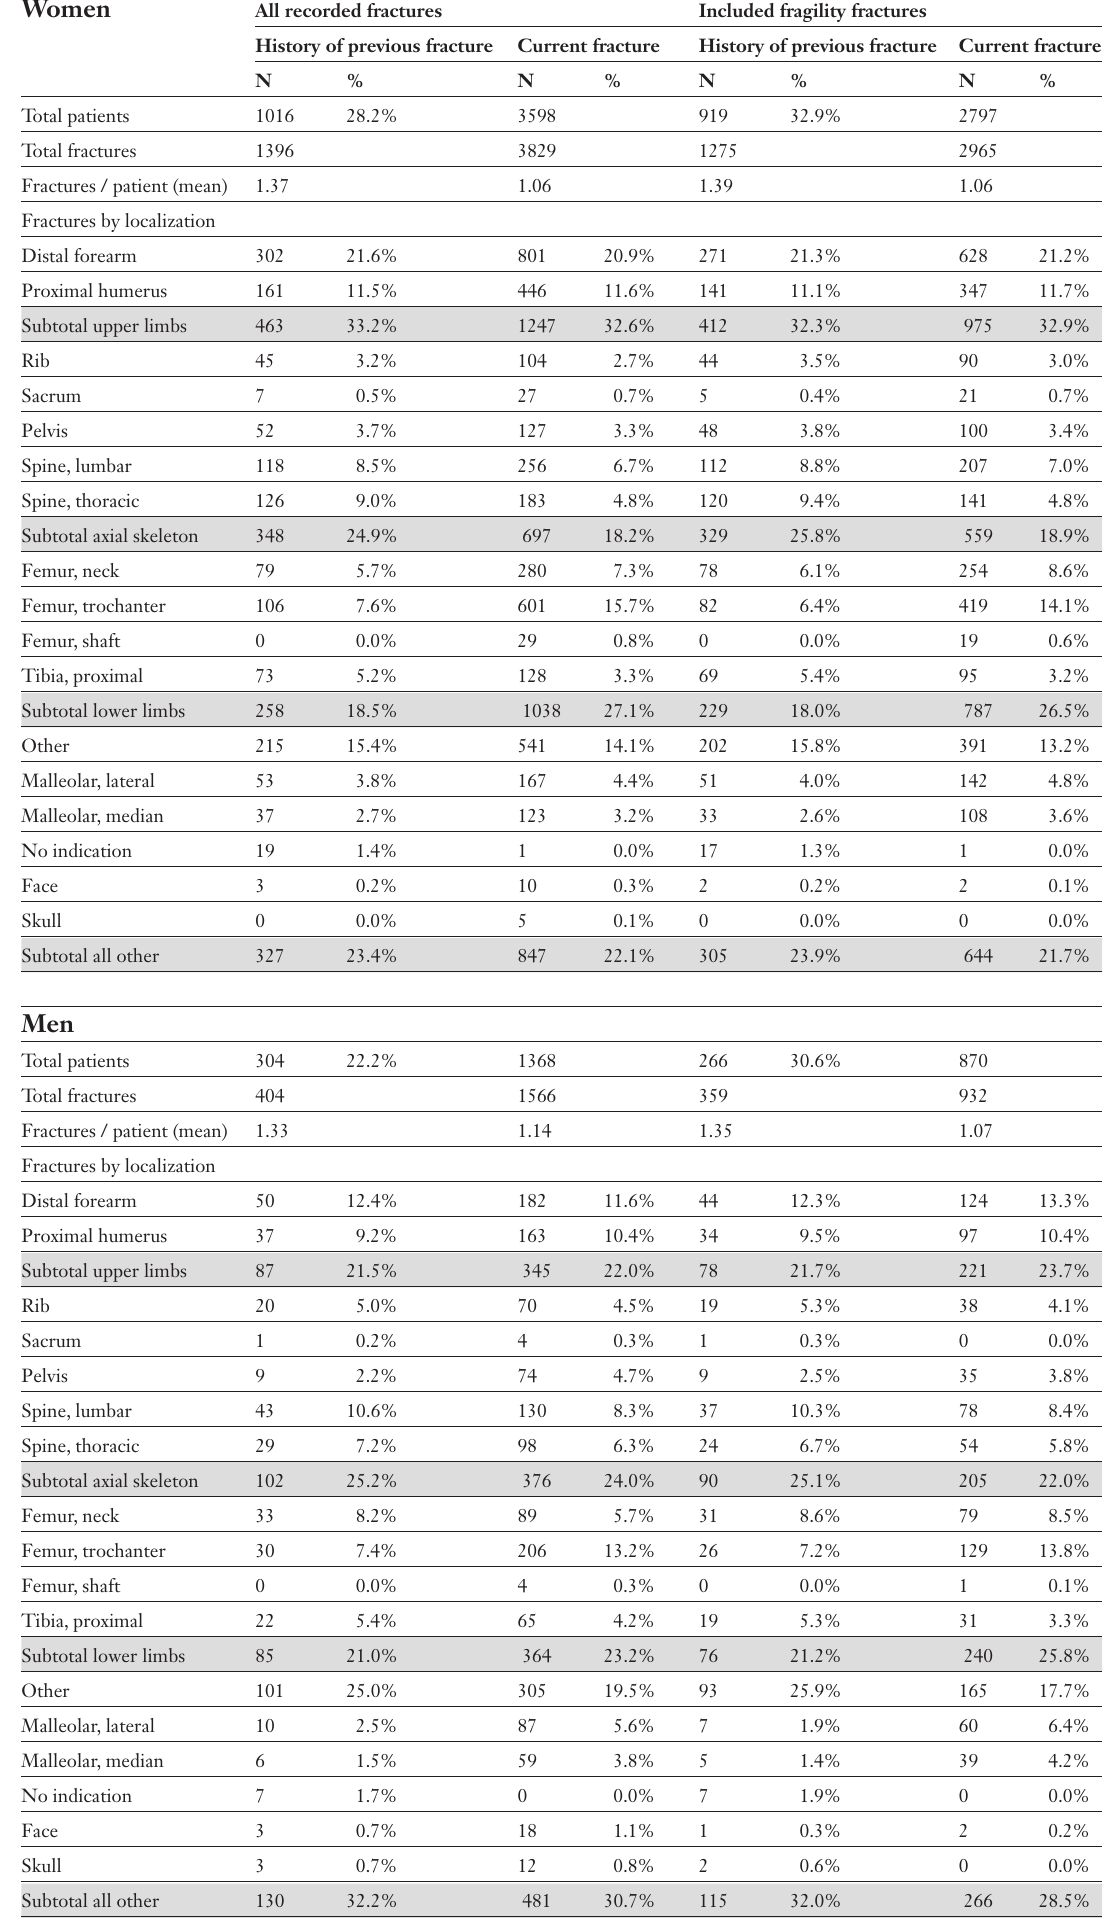
Table 1 Distribution of frac- tures in all recorded patients (n = 4966) and in included pa- tients with a fragility fracture (n = 3667), by gender and frac- ture type. Some pa- tients had multiple